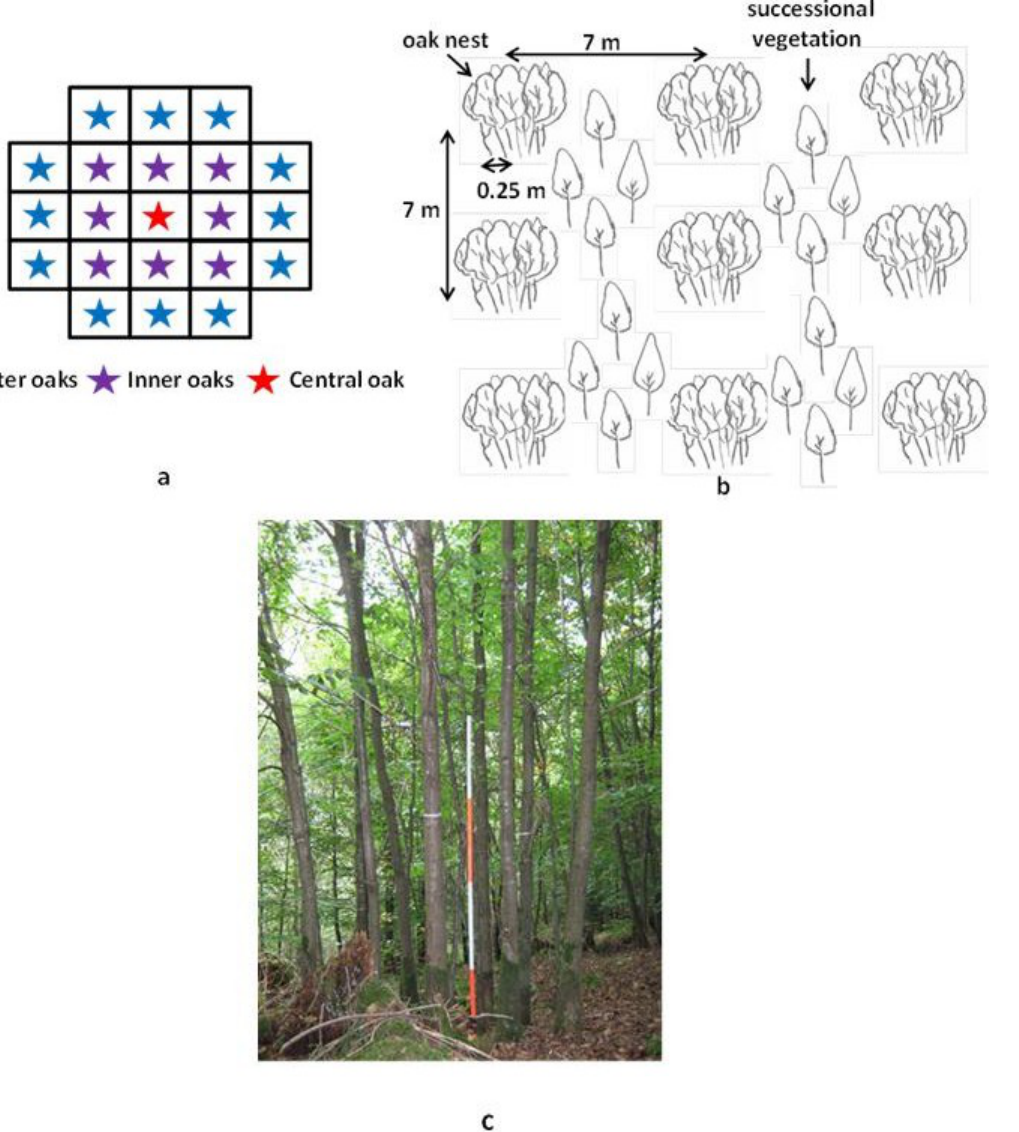
Figure 1. ( a ) Szymanski’s (1986) nest design; ( b ) 7 × 7 m spacing between the centres of nests were generally followed in German nest plantings; ( c ) 23-year-old nest planting in Leonberg, Baden-Württemberg,